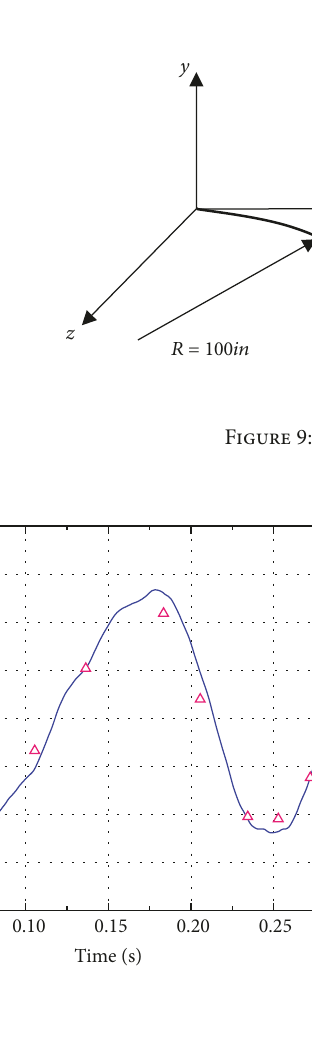
Figure 10: Z-direction displacement of beam free end.